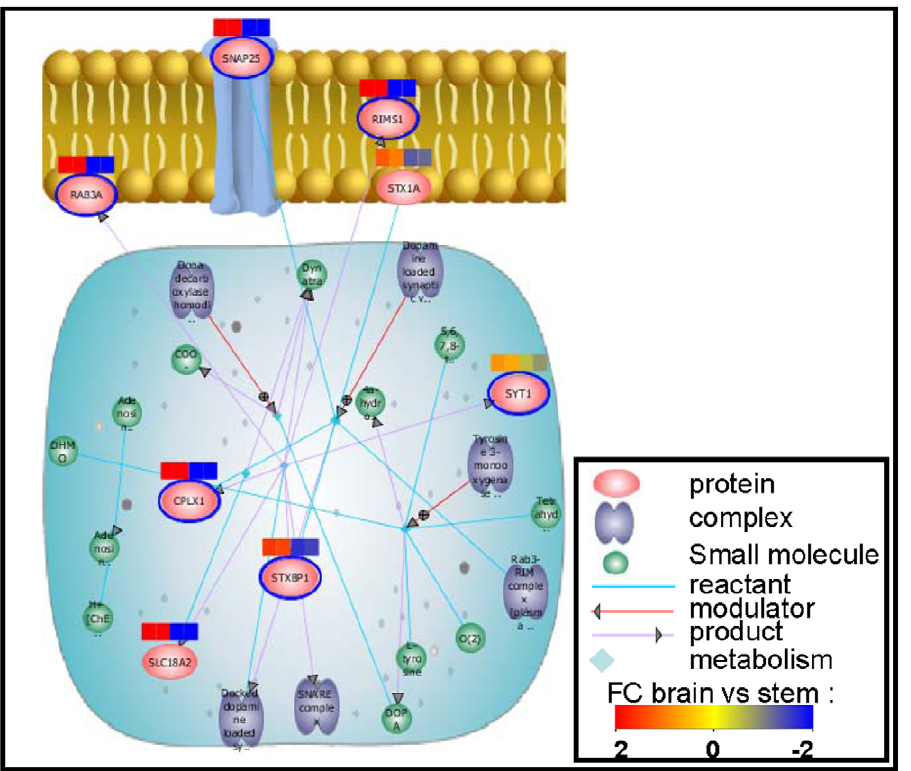
Figure 3. Dopamine neurotransmitter release cycle pathway. The 1830 up-regulated mRNA set are significantly enriched by mRNA coding for proteins involved in ‘‘dopamine neurotransmitter release cycle’’ pathway. The network was generated by ‘‘find significant pathway’’ function in GeneSpring GX v11 (p , 0.05). Connections were based on known interactions between these proteins within the Reactome database. The biological relationship between two proteins is represented as a line (an edge). The proteins with a blue halo belong to the 1830 mRNA up-regulated set in brain vs stem cells. Red and blue colored squares indicate genes with up- and down-regulated expression, respectively. The intensity of the colors highlights the fold change (FC) in brain vs stem cells samples. The nature of the relationships between the proteins are shown in legend. SNAP25, synaptosomal-assiociated protein 25; RIMS1, regulating synaptic membrane 1; RAB3A, RAB3A interacting protein; SYT1, synaptotagmin; CPLX1, complexin 1; STXBP1, syntaxin binding protein 1.